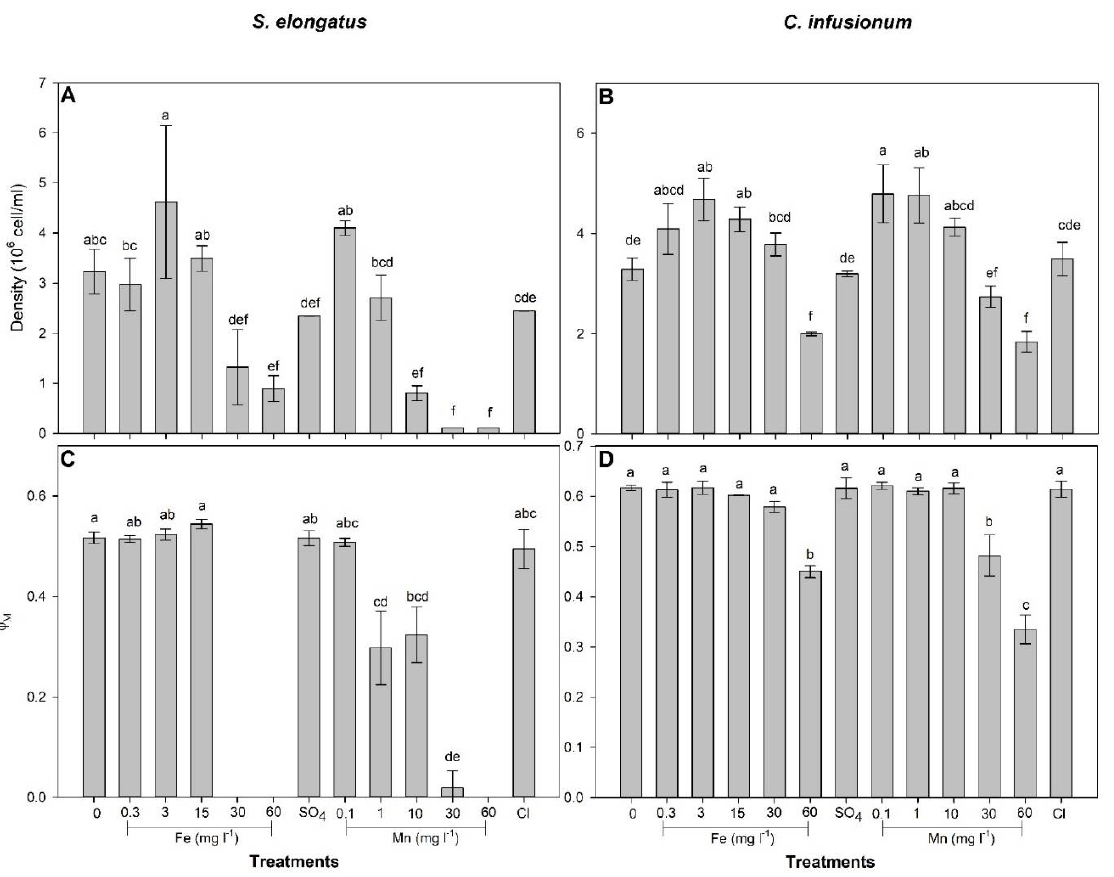
Figure 1. Cell density ( A and B ) and maximal PSII photochemical yield ( M ) ( C and D ) in Synechococcus elongatus and Chlorococcum infusionum exposed to increased concentrations of Fe or Mn (mg l −1 ) or to 103.20 mg SO 4 l −1 and 77.45 mg Cl l −1 for 96 h. Bars represent means ± SD of six replicates. Different letters indicate significant difference ( p > 0.05) by the post hoc Tukey test.